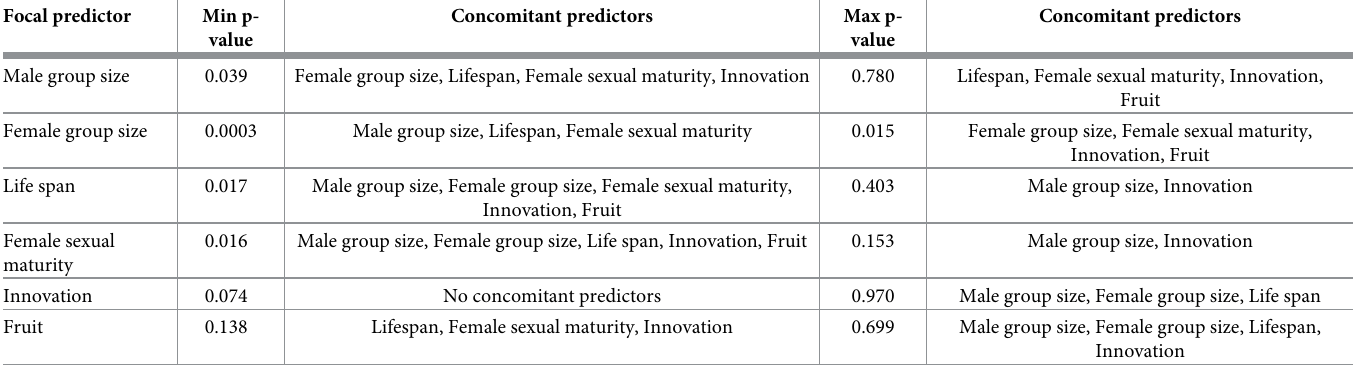
Table 6. The change in p-value for each predictor when altering concomitant predictors using neocortex size as dependent variable. Read as follows: the focal predic- tor in the first column was estimated to a lowest p-value (out of all the 32 models the focal predictor where included in) shown in the second column when using the con- comitant predictors shown in column three. Likewise, the maximum p-value shown in column four, were estimated using concomitant predictors in column five. N =